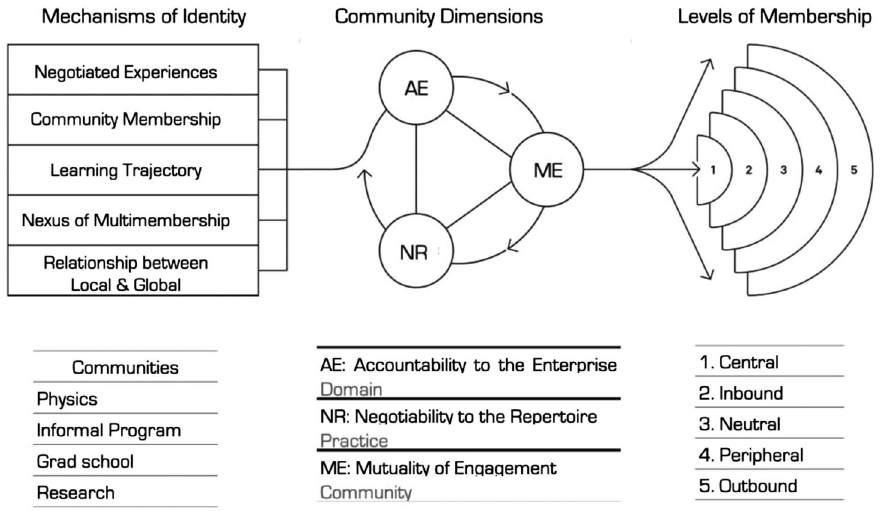
FIG. 5. The community of practice framework as it was structured to study university students ’ physics identity development in informal physics programs. In this structure, the mechanisms of identity act on the community dimensions, prompting changes in students ’ levels of membership within the community of practice and therefore their